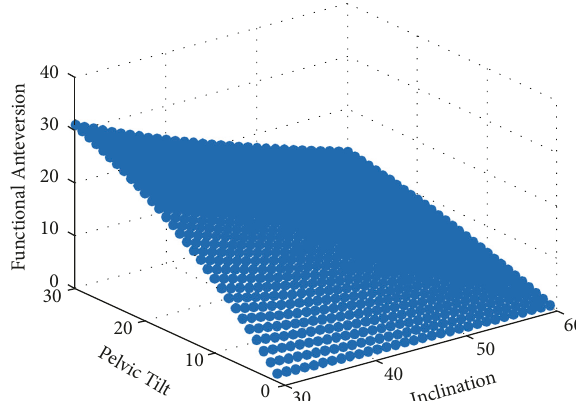
Figure 2: Example relationship generated to calculated change in functional anteversion based on inclination, pelvic tilt, and in this graphical example with anteversion held constant at 20 ∘ .